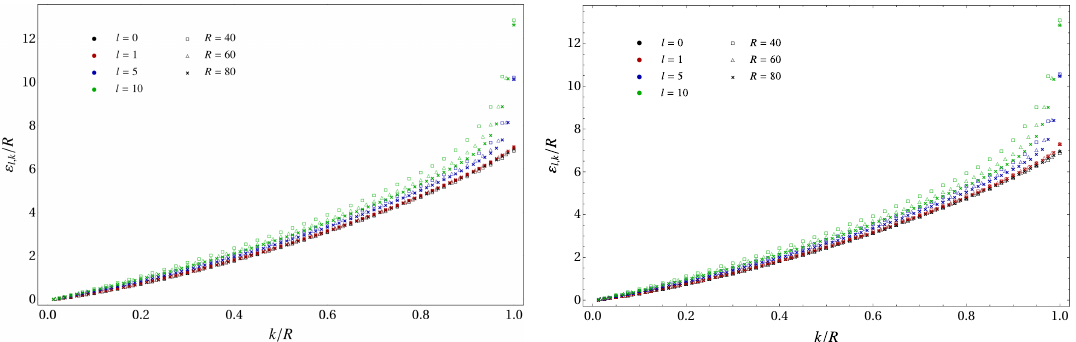
Figure 6. Single particle entanglement energies at given l in the case of ω = 0 when d = 2 (left panel) and d = 3 (right panel), for various values of l and R .